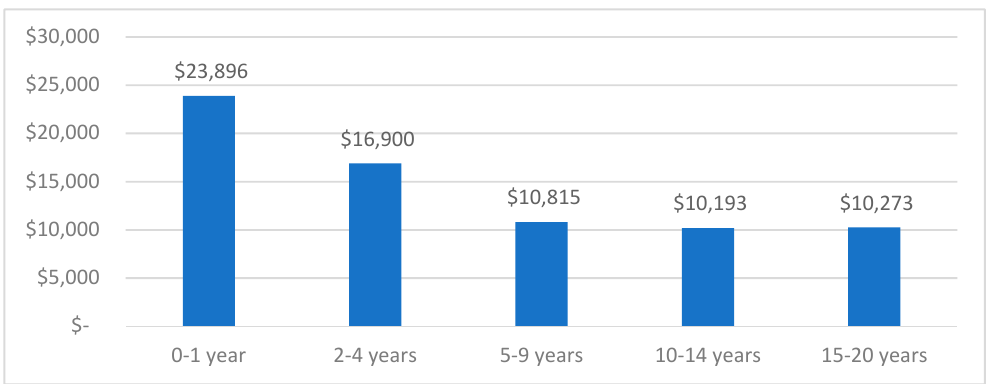
Figure 4. Mean healthcare costs (2016) per person in AU$ with vital status alive in 2016 by time since diagnosis (N = 203,495).